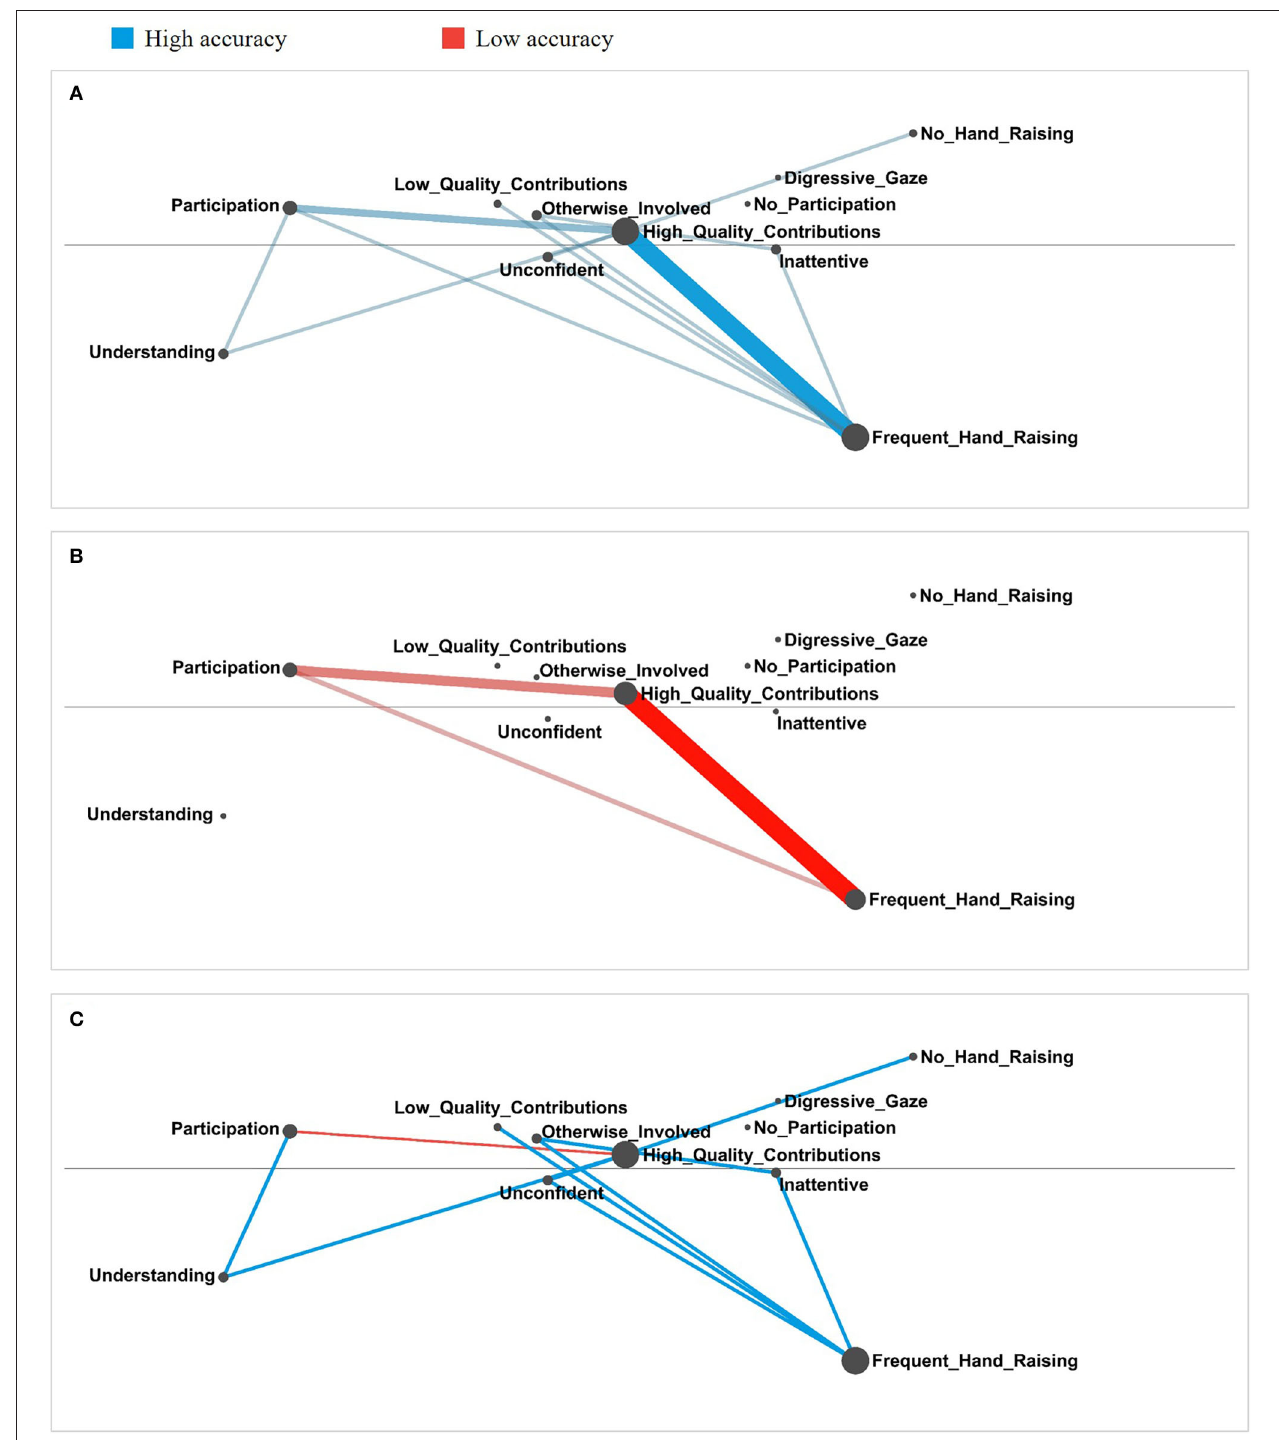
FIGURE 9 | Comparison of networks for overestimating student profile between student teachers with high and low judgment accuracy. (A) Depicts the network of the overestimating student profile for student teachers with high accuracy. (B) Depicts the network of the overestimating student profile for student teachers with low accuracy. (C) Shows the comparison of both networks. Here, the color of connections indicates which group utilized the respective code combination more frequently. In order to make the characteristics of the individual networks clearly visible and to make the differences visually easier to recognize, minimum edge weight, and scale for edge weight were set to 0.1 and 1.3,